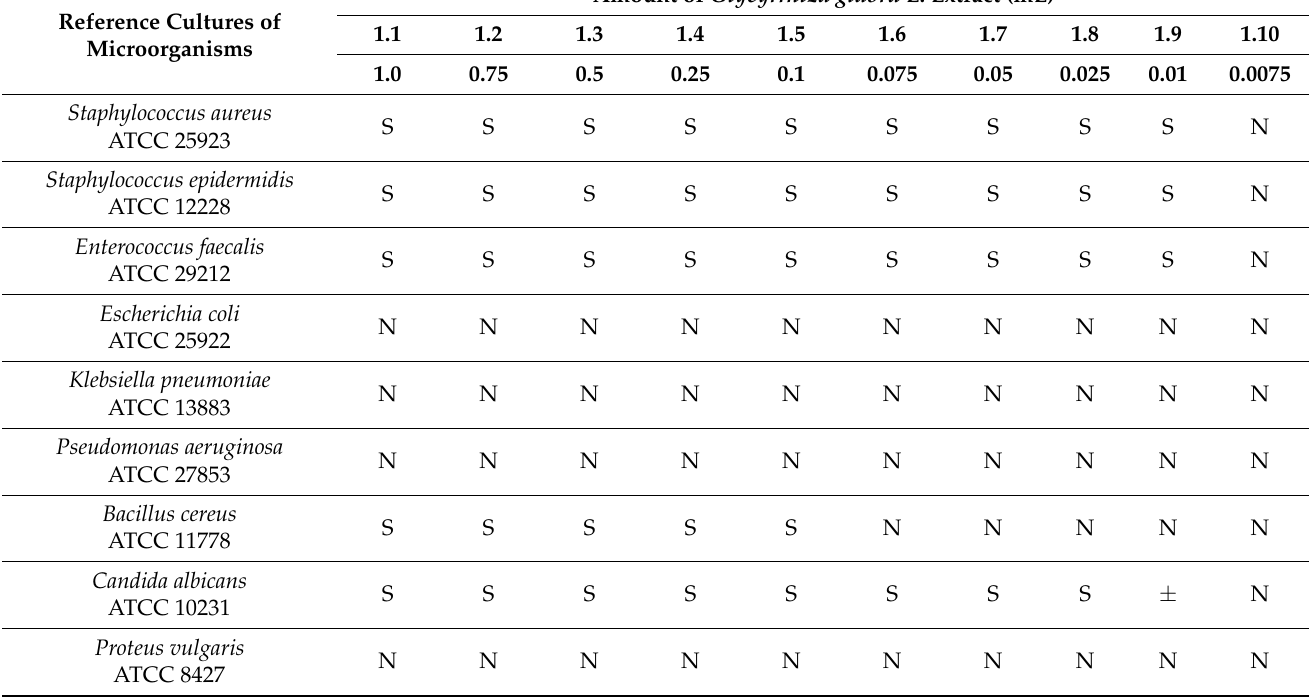
Table 3. Antimicrobial effect of Glycyrrhiza glabra L. extract on the growth of reference microor- ganism